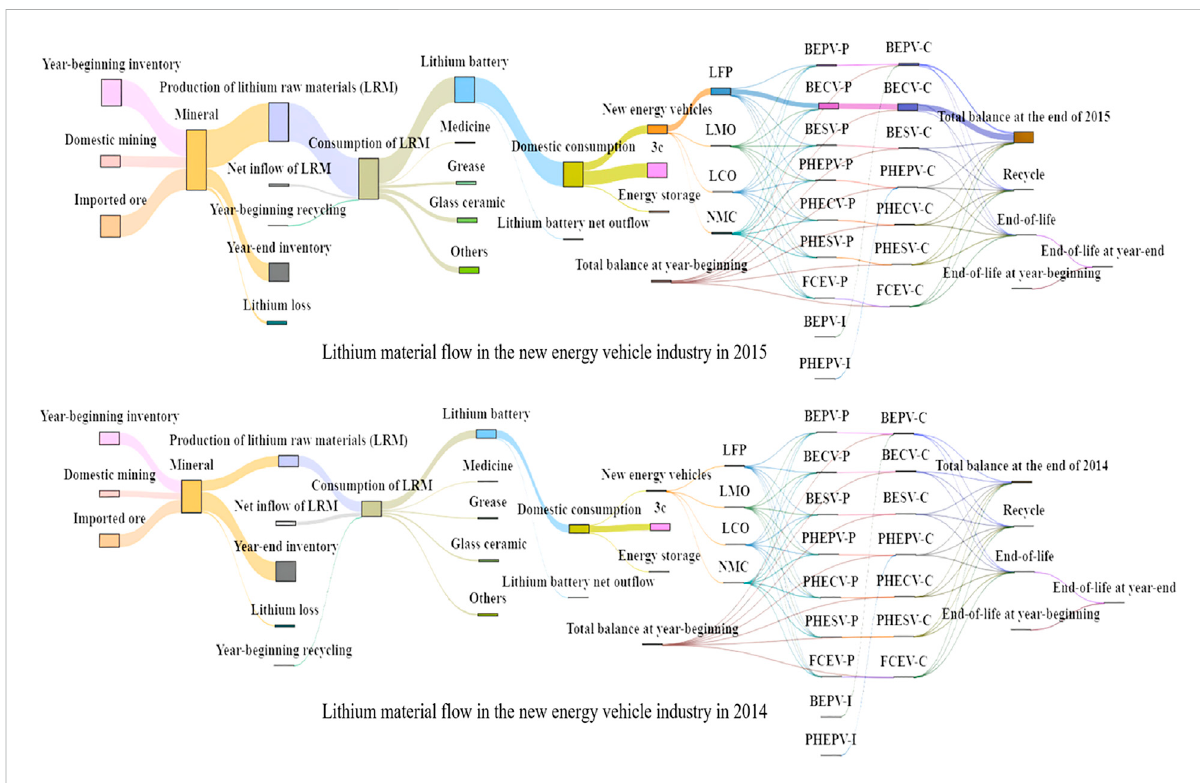
FIGURE 6 Lithium material fl ow in the new energy vehicle industry in 2014 –